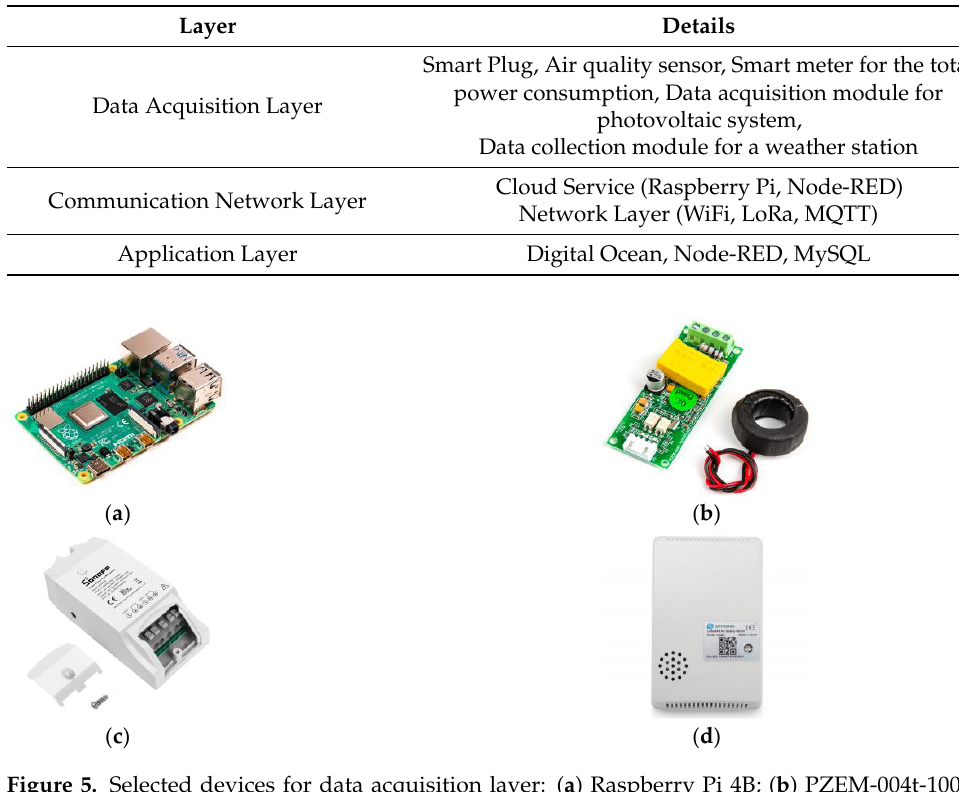
Table 3. List of sensors and measuring devices used for the testbed.